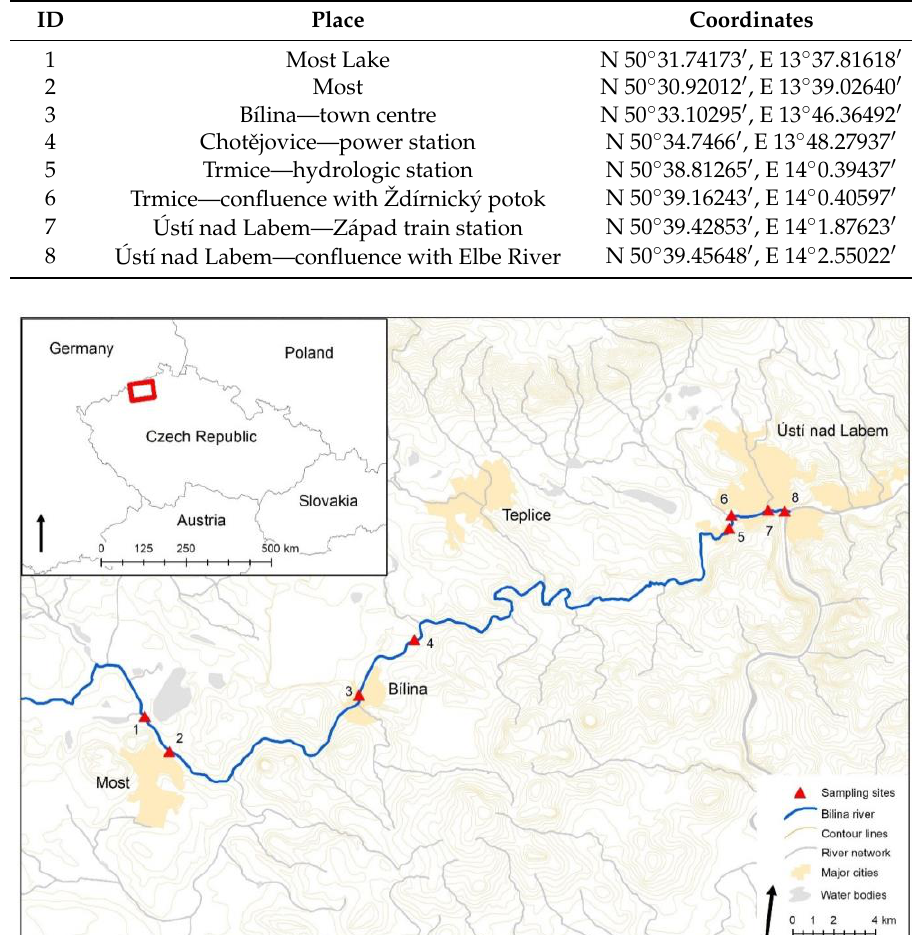
Figure 1. Map of the Bílina river with sampling sites.